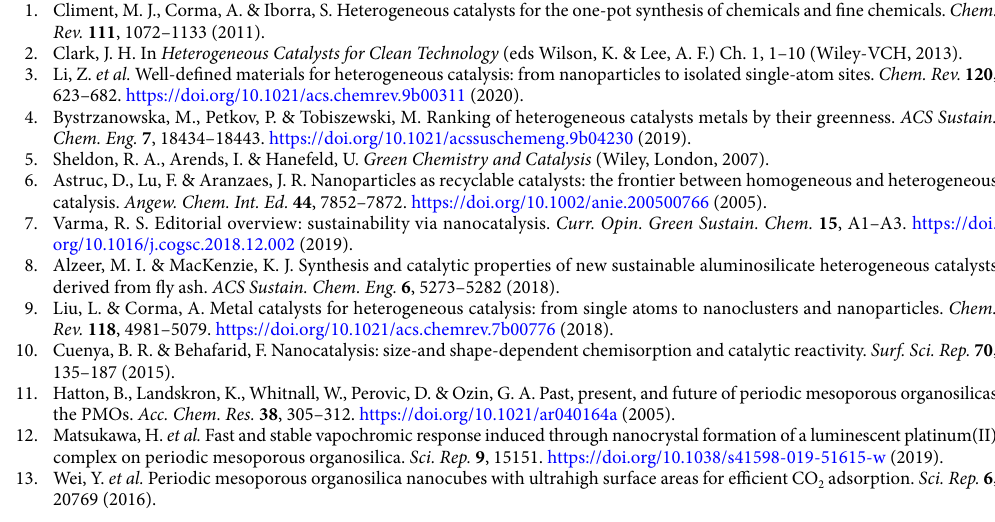
Table 3. Comparison of the catalytic efficiency of the Iron oxide@PMO-ICS-PrSO 3 H solid acid ( 1 ) with other catalytic systems for the synthesis of 6a .